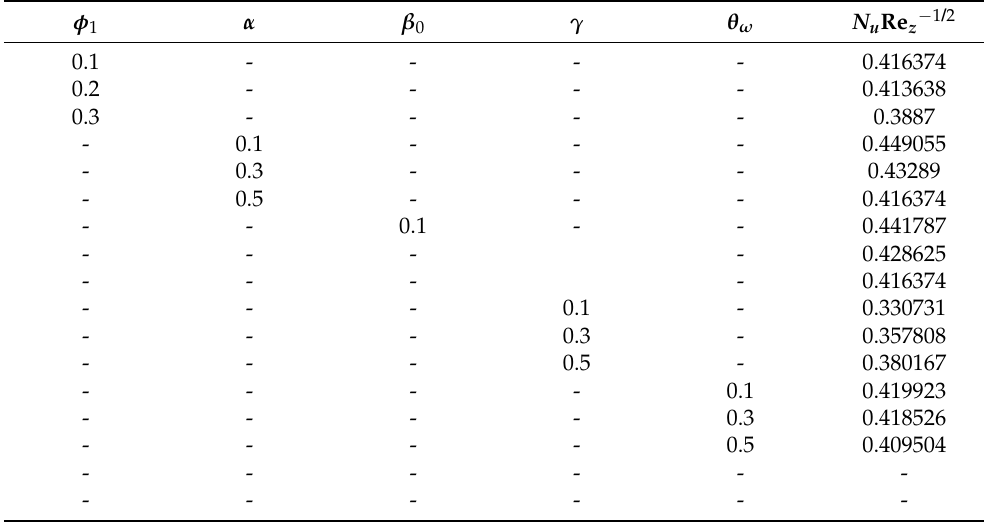
Table 3. The variation in Nusselt number for numerous values of φ 1 , α , β 0 , γ , and θ ω .